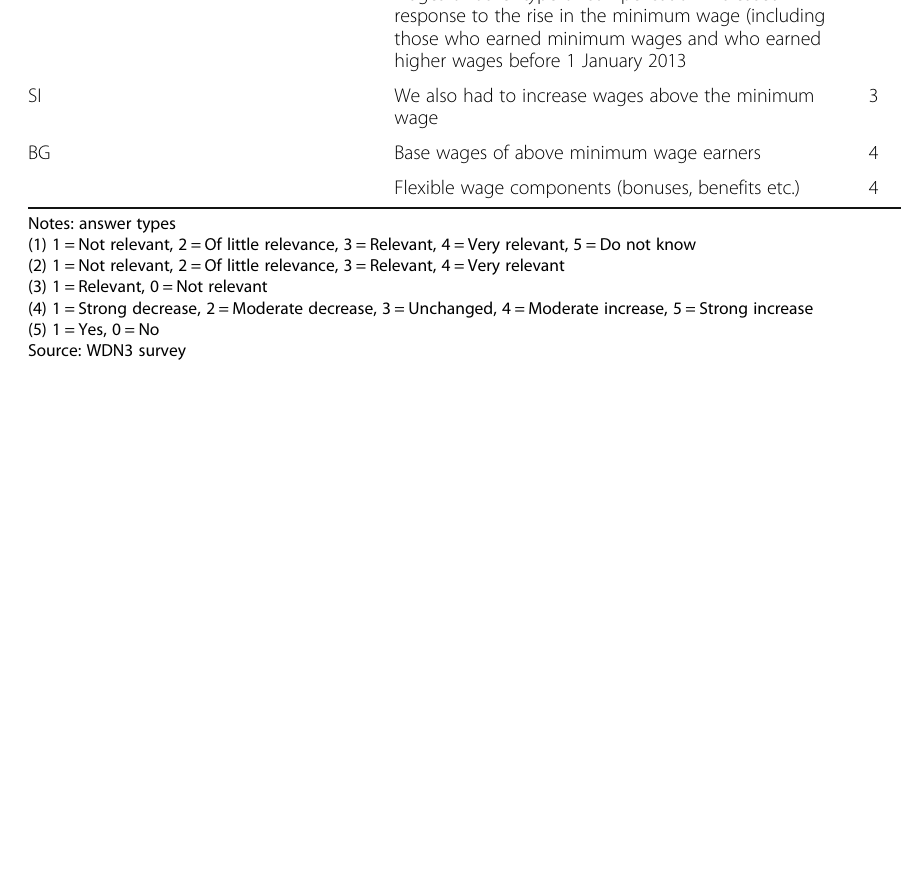
SI We also had to increase wages above the minimum wage BG Base wages of above minimum wage earners 4 Flexible wage components (bonuses, benefits etc.)